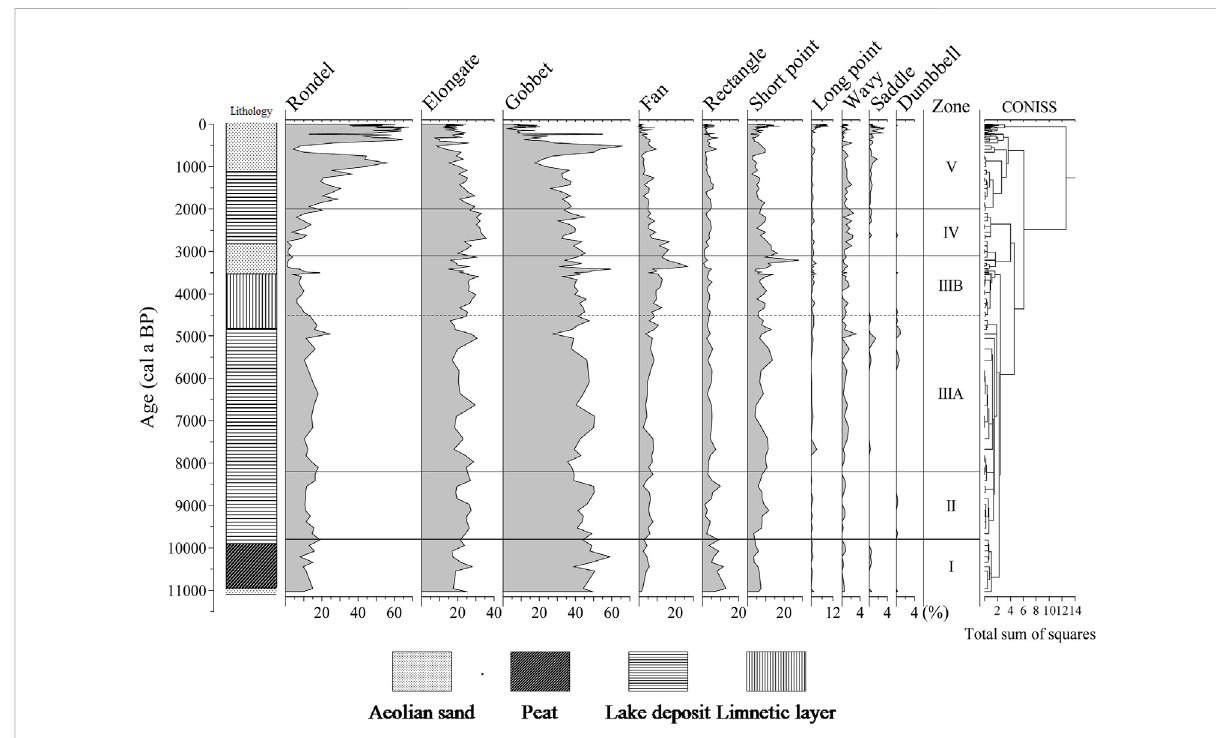
Phytolith assemblage observed fromZZH pro fi leintheBadain JaranDesert.ZoneI,zoneII,zoneIII,zoneIV, andzoneVindicate the11 – 9.8 cal ka BP, 9.8 – 8.2 cal ka BP, 8.2 – 3.1 cal ka BP, 3.1 – 2 cal ka BP, and 2 cal ka BP to the present,